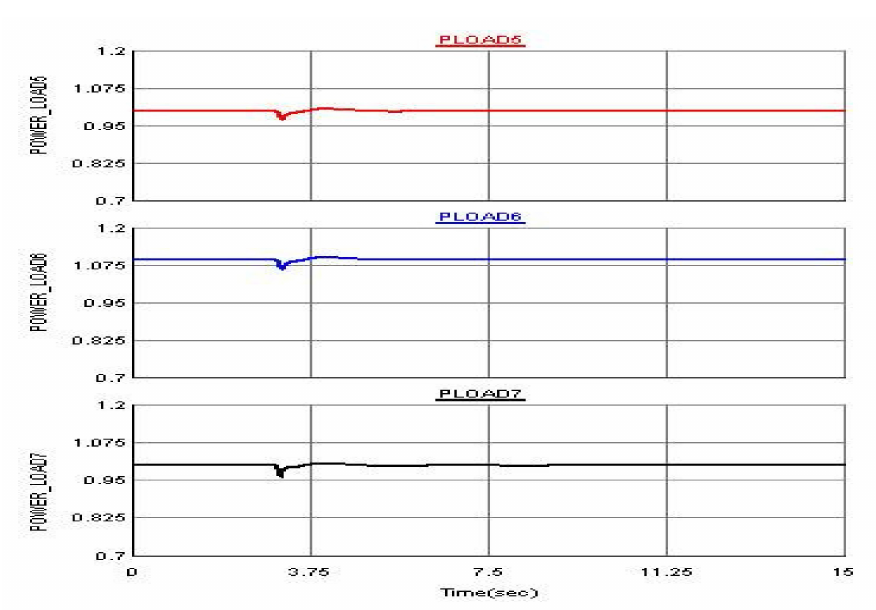
Figure 14. Critical load active powers (Loads at Buses